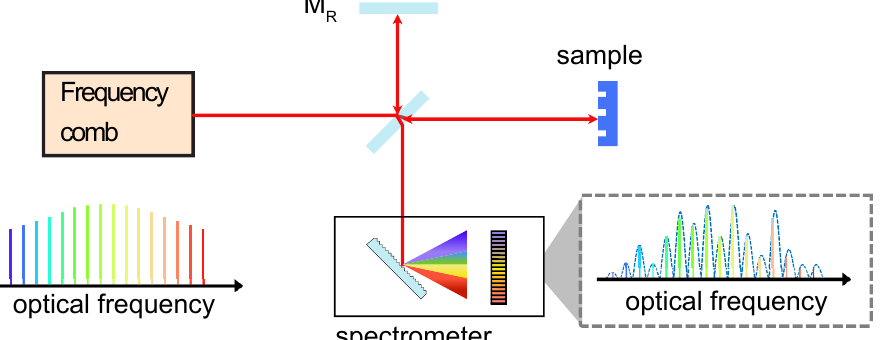
Figure 4. White light interferometer using a frequency comb. The light of the comb is split in two parts using a beam splitter, then is directed to the fixed reference mirror (M R ) and the surface of the sample. The reference and measurement beams are recombined to produce the interference signal detected by the CCD’s